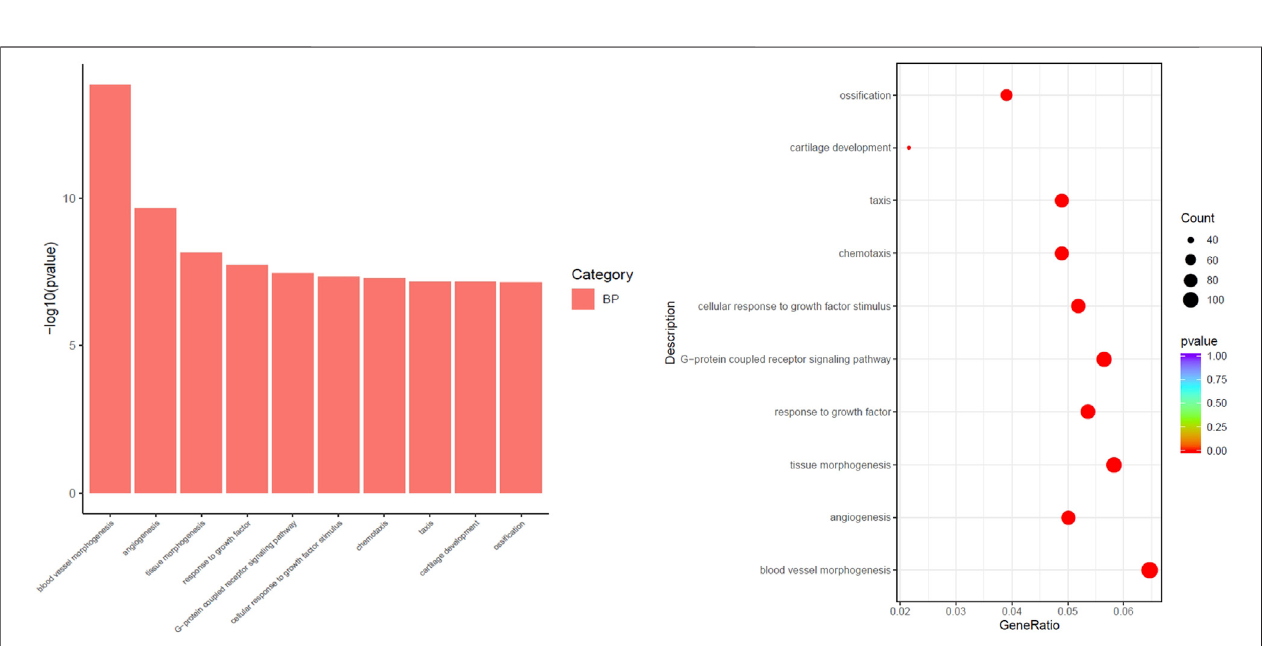
FIGURE 5 | Different biological process of upregulation in the group with SKYD syndrome compared with the group with PDR syndrome.